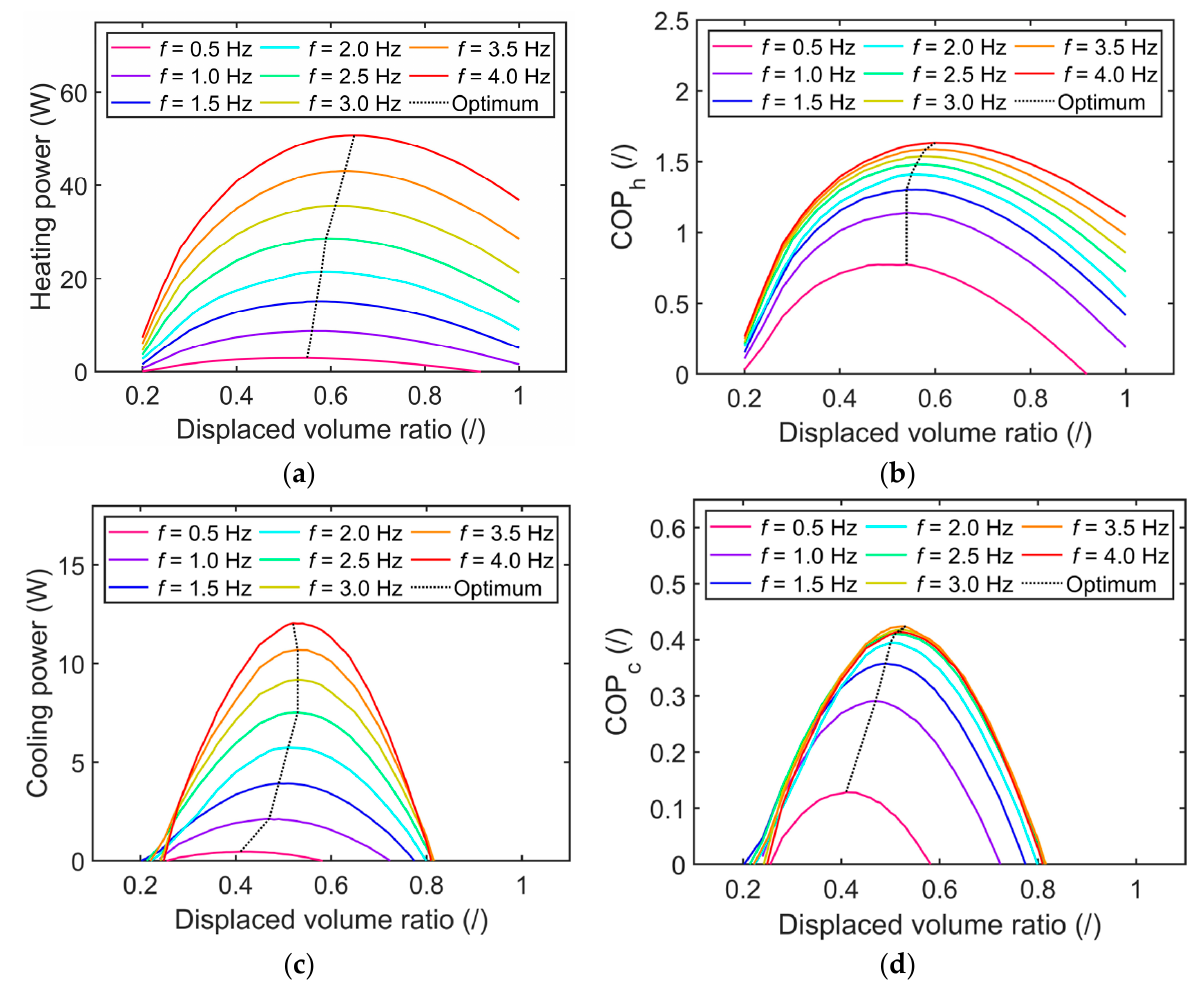
Figure 12. The effect of displaced volume ratio and frequency on AeCR performance at a fixed strain of 2.7% and temperature span of 15 K (based on inlet fluid temperatures) for heat-pumping ( a , b ) and cooling ( c , d ).